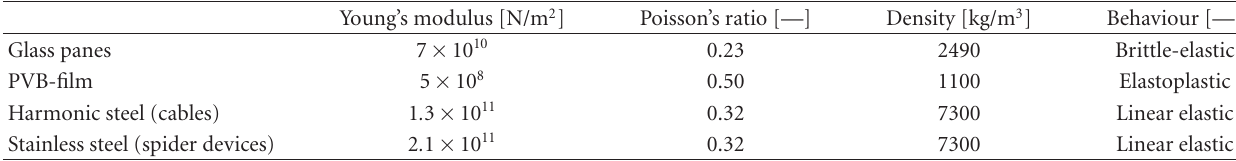
Table 1: Material properties (M01